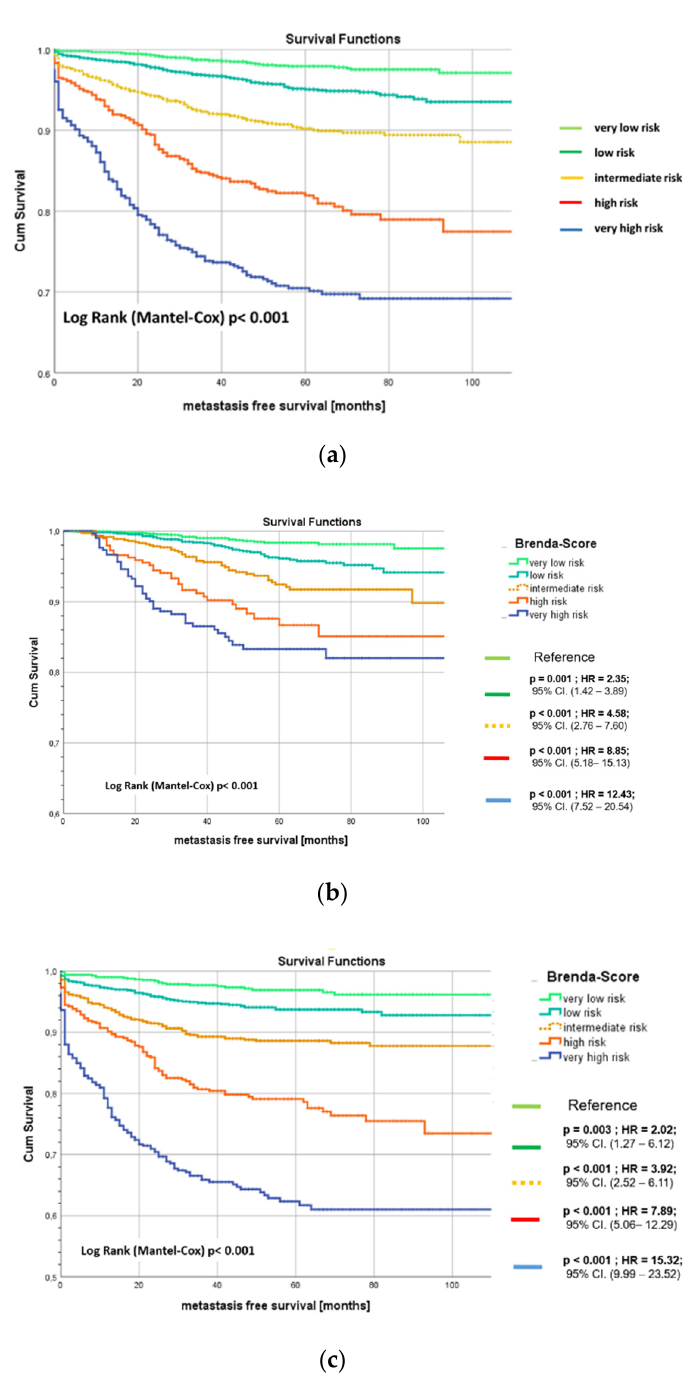
Figure 1. ( a ) Kaplan-Meier metastasis-free survival (MFS) curves of the derivation set stratified by BRENDA-Score (BRENDA DB) with 110 months. Very low risk = light green, low risk = green, intermediate risk = yellow, high risk = orange, very high risk = blue line. ( b ) and ( c ) Subgroup analysis with guideline adherent ( b ) and non-adherent ( c ) treatment Kaplan-Meier metastasis-free survival (MFS) curves of the derivation set stratified by BRENDA-Score (BRENDA DB) with 110 months. Very low risk = light green, low risk = green, intermediate risk = yellow, high risk = orange, very high risk = blue line.